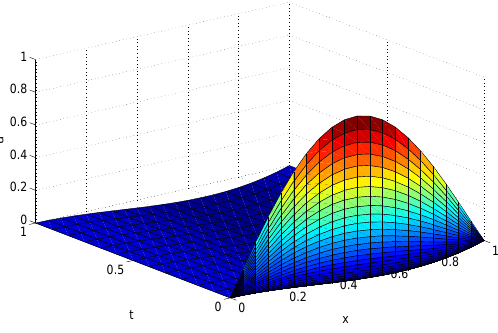
Figure 3: Numerical solution with ε = 10 −4 for Example